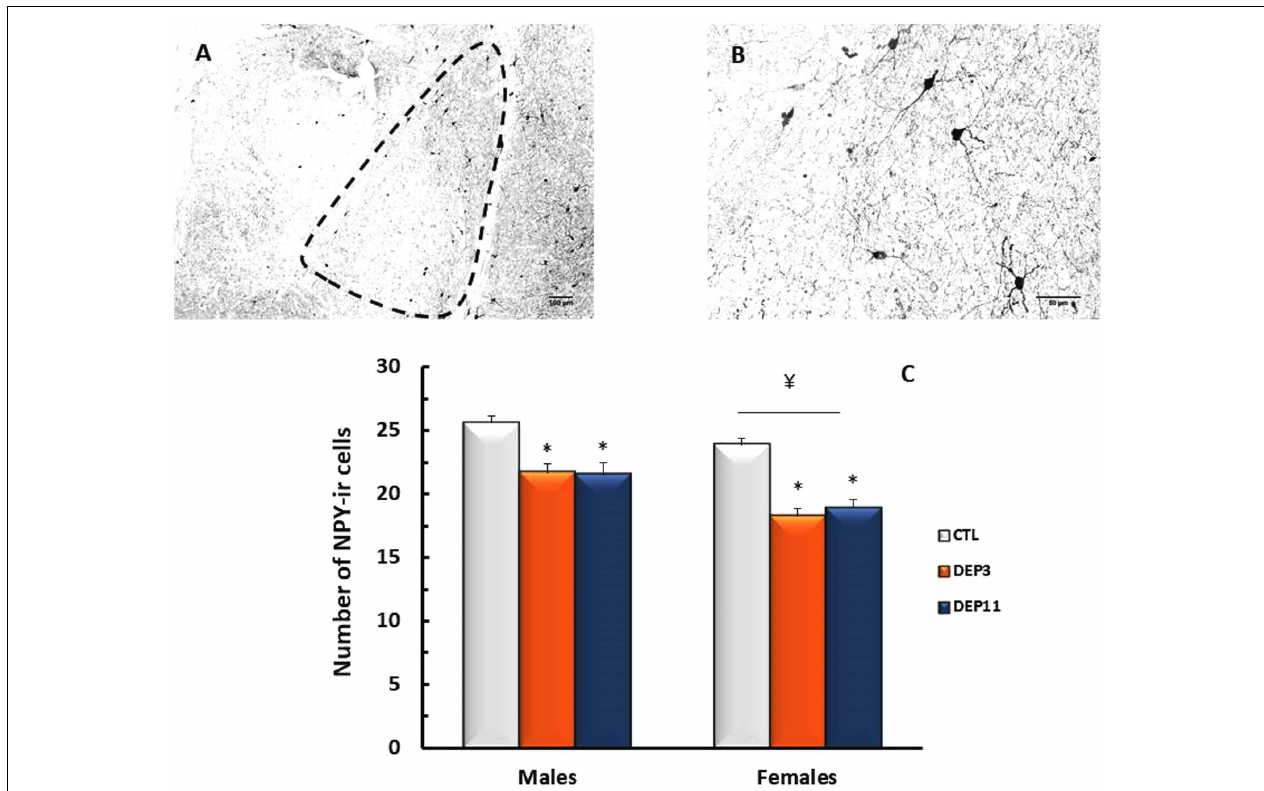
FIGURE 5 | Photomicrograph of the basolateral amygdala (BLA) of one control rat at 10x (A) and 40x magnification (B) . Number of NPY-immunoreactive neurons in the BLA (C) of animals maintained with their mothers (CTL), deprived on postnatal day (PND) 3 (DEP3) or on PND 11 (DEP11) and perfused between PNDs 52 and 60. Data are presented as mean ± SEM of 11–15 males and 10–12 females/group. Scale bar in A = 100 µ m; scale bar in B = 50 µ m. ∗ – Different from CTL group; (cid:85) – different from respective male